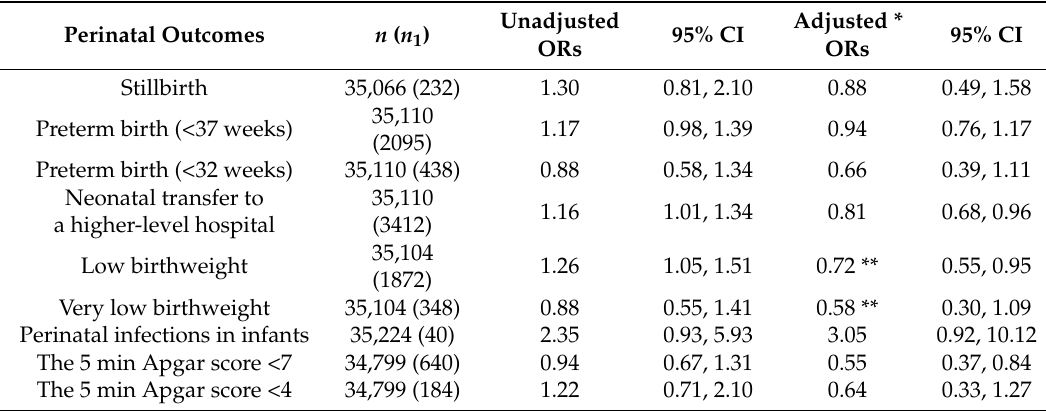
Table 3. The crude and adjusted odds ratios for adverse pregnancy outcomes in adolescents, the ACBR, Russia,